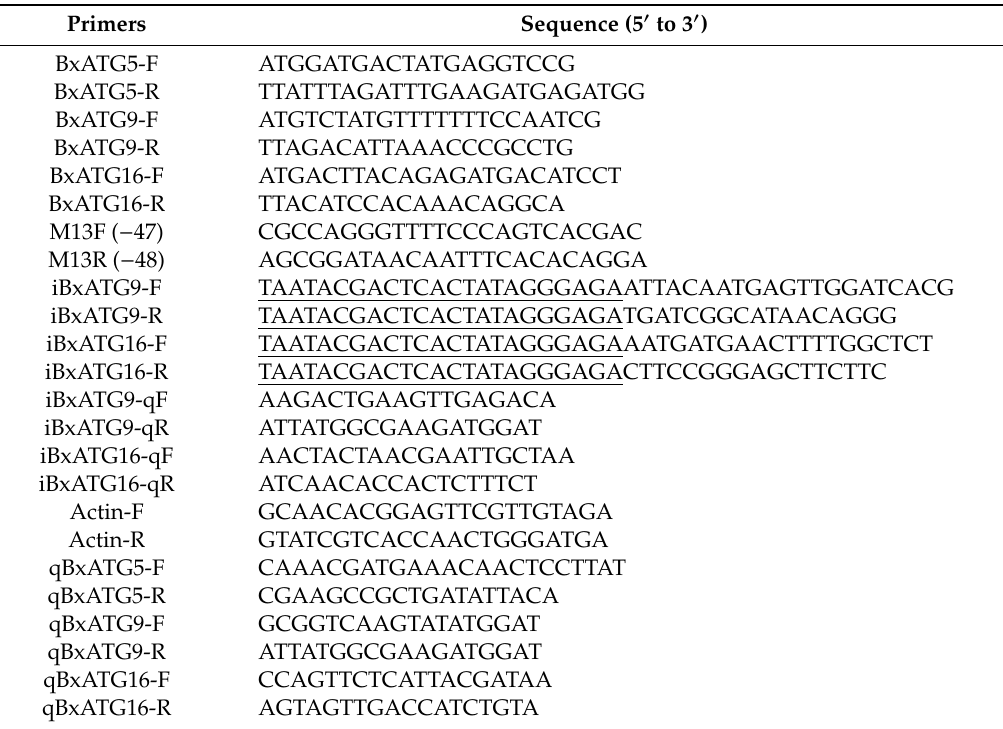
Table 1. PCR primers used in the